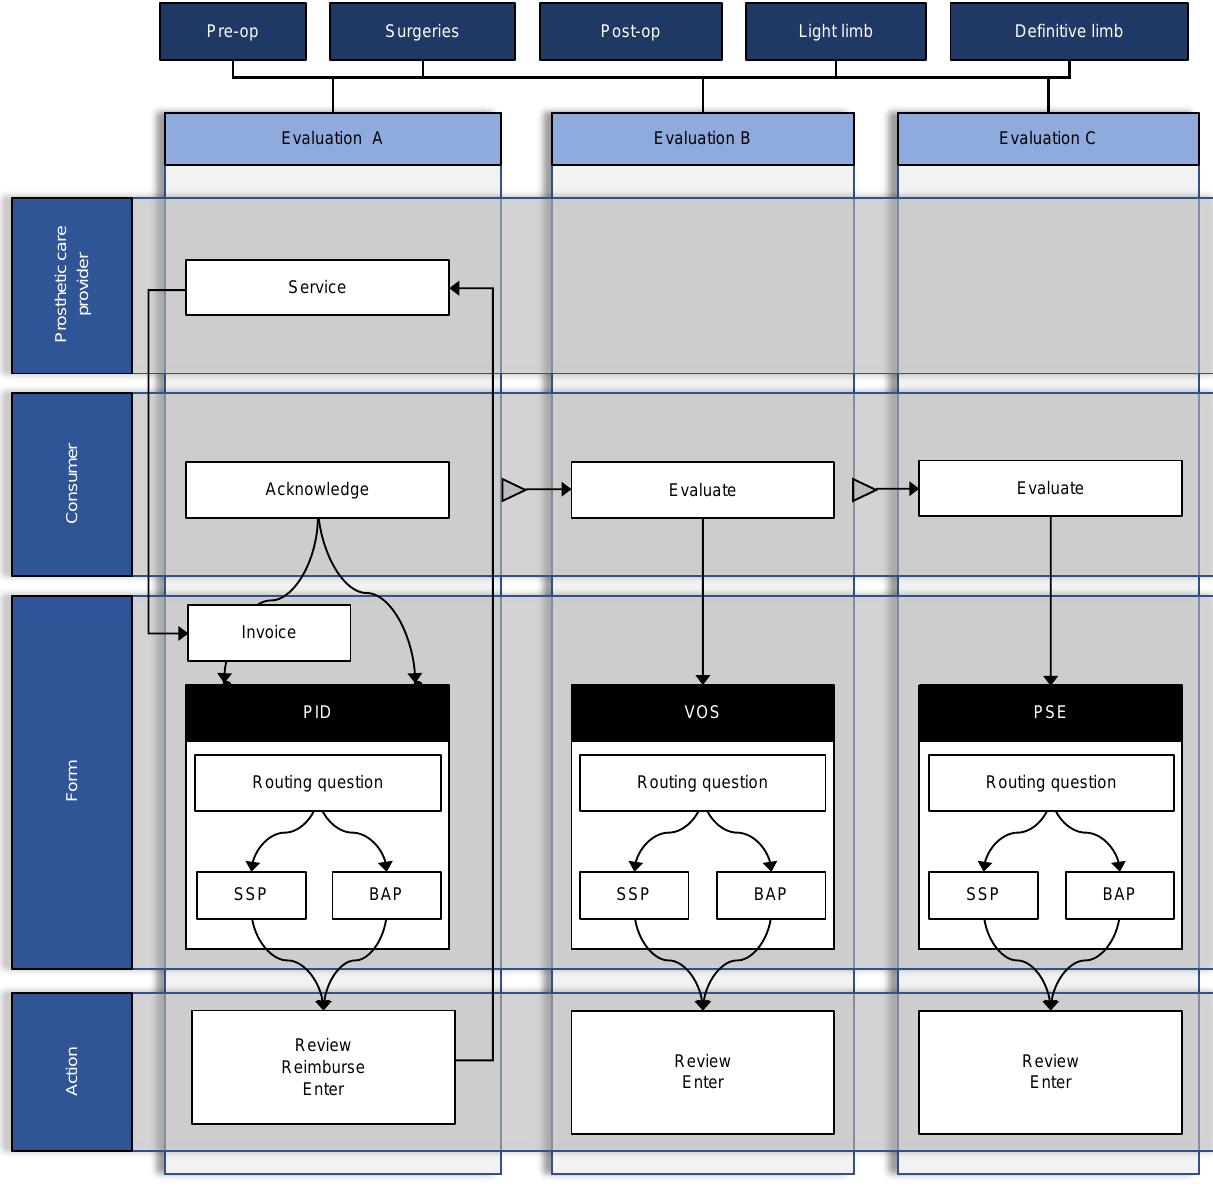
Figure 4: Overview of continuous quality improvement (CQI) procedure seeking to enhance Queensland Artificial Limb Service (QALS) consumer’ experience with the provision of socket-suspended (SSP) and bone-anchored (BAP) prostheses that involved collection of data with prosthetic care providers and consumers (PID: Prosthetic Issue Document, VOS: Validation of Services, PSE: Prosthetic Service Evaluation). Adapted from Frossard et al (2018).